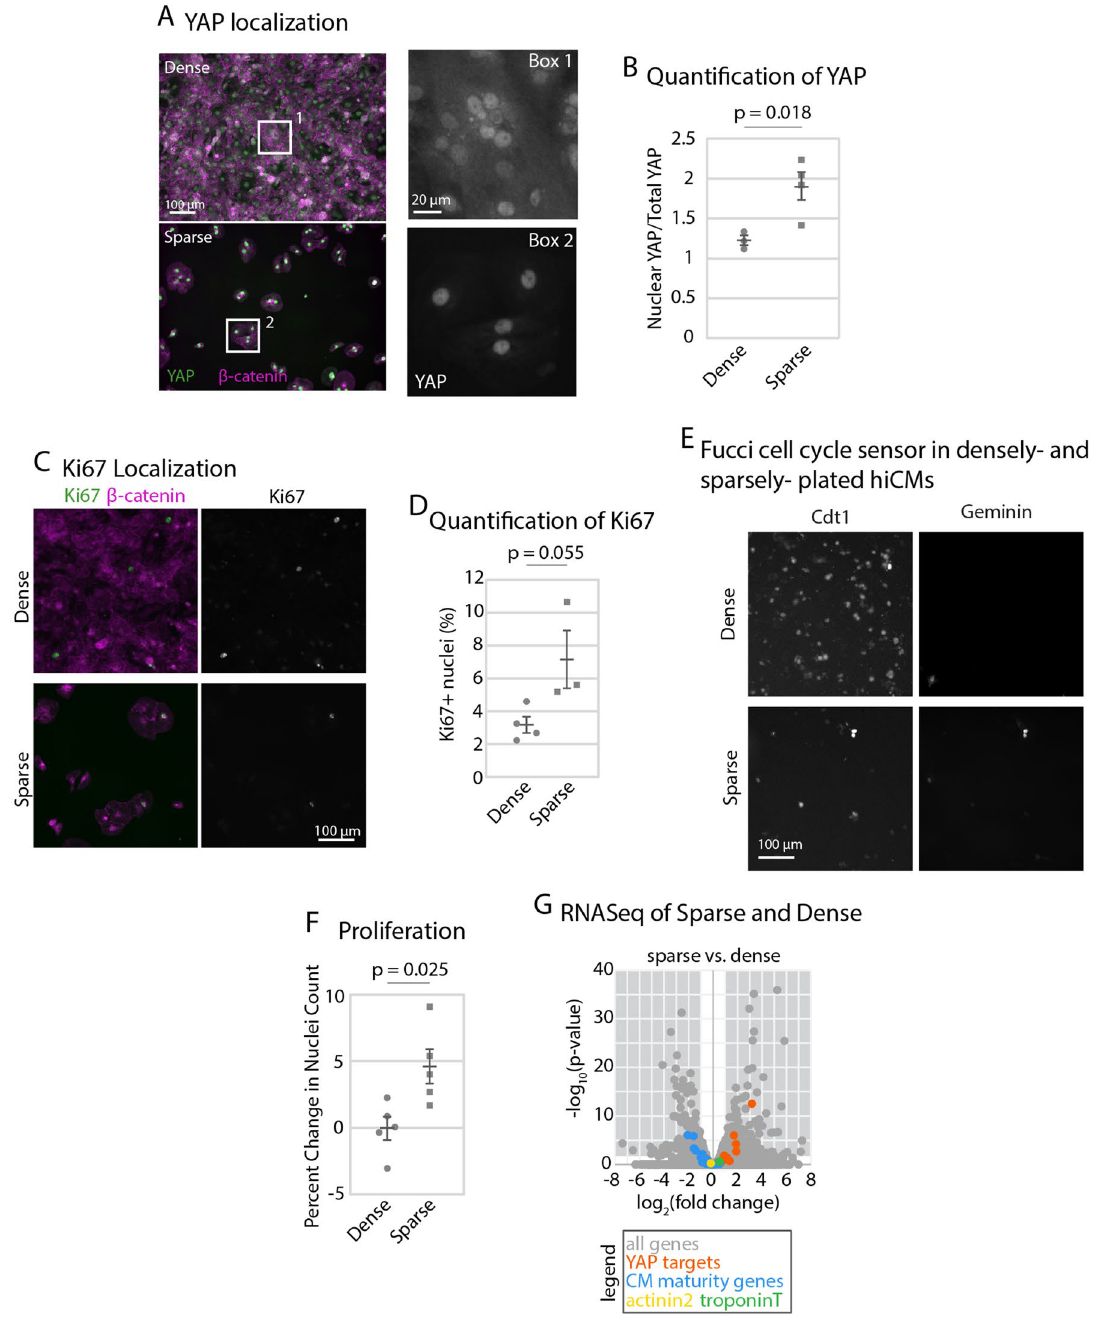
Figure 2. Reducing hiCM density by sparse plating increases proliferative capacity. ( A ) YAP and β-catenin in dense and sparse hiCMs using 20 × widefield fluorescence microscopy. ( B ) Quantification of nuclear/total YAP ratio. Significance determined by paired two-tailed Student’s t test. (N = 23 dense cells and 27 sparse cells from 3 independent experiments) ( C ) Ki67 and β-catenin immunolocalization in dense and sparse hiCMs using 20 × widefield fluorescence microscopy. ( D ) Percent of Ki67-positive nuclei in dense (N = 8046 hiCMs from 4 experiments) and sparse (N = 1716 cells from 3 experiments) hiCMs. Significance determined by an unpaired two-tailed Student’s t test. ( E ) Fucci cell cycle probe transduced into dense or sparse hiCMs. Arrows shows S–M phase. ( F ) Proliferation of dense or sparse hiCMs quantified by counting nuclei fold change over 48 h (N = 281,250 cells from 5 independent experiments). Significance determined by unpaired two-tailed Student’s t test. ( G ) RNASeq Volcano plot of genes significantly changed in sparse versus dense hiCMs (N = 300,000 hiCMs per treatment from 3 independent experiments). A negative fold change represents a downregulation in sparse hiCMs. A positive fold change represents an upregulation in sparse hiCMs. Gene names of determined YAP target genes (including CTGF and CYR61), cardiac myocyte identity genes (TNNT2 and ACTN2), and cardiac myocyte maturity genes (including GATA4 and FOXOD) can be found in Tables 1, 2,